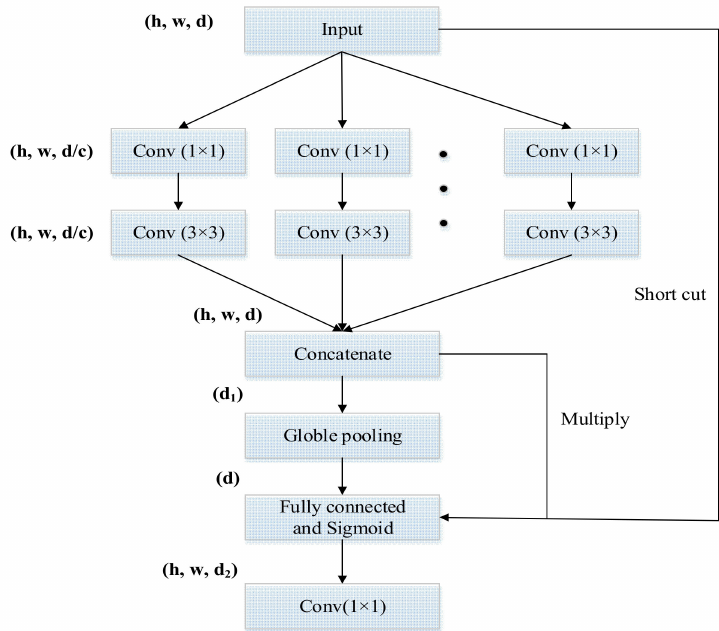
Figure 4. Grouped attention block.